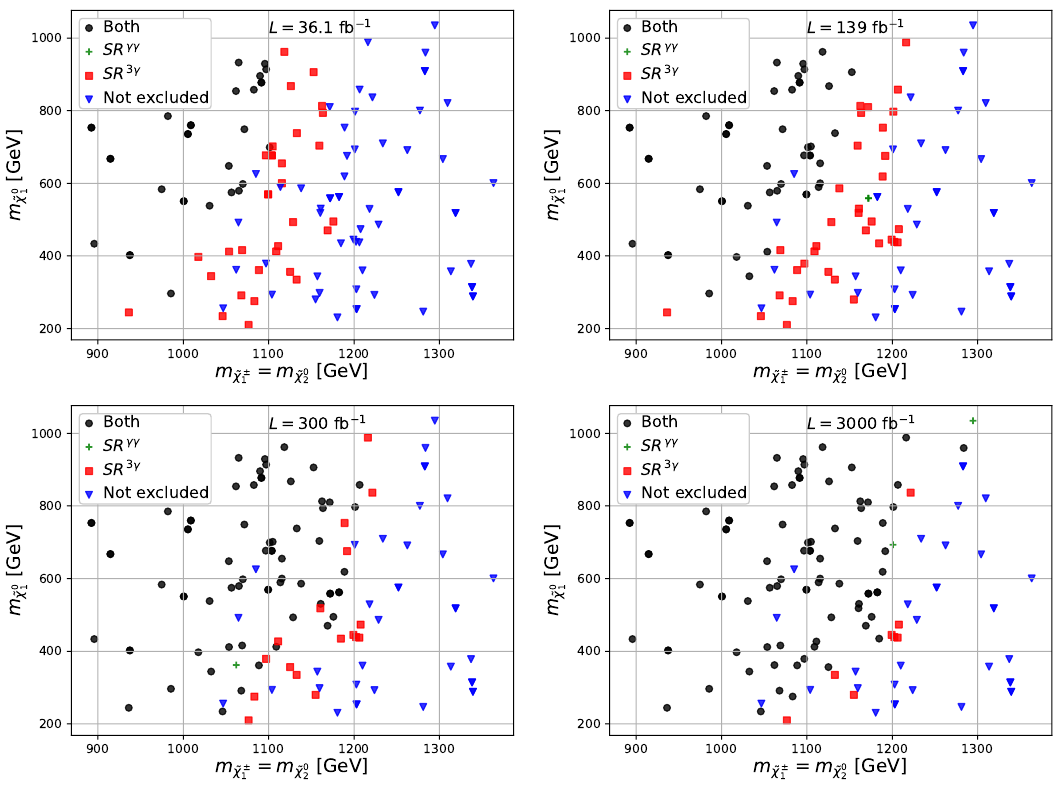
Figure 6 . Exclusion results for the benchmark points from section 3 for the four luminosity scenarios. Black circles depict benchmark points excluded by both SR γγ and SR 3 γ , green crosses are excluded only by SR γγ , red squares are excluded only by SR 3 γ and blue triangles are excluded neither by SR γγ nor SR 3 γ